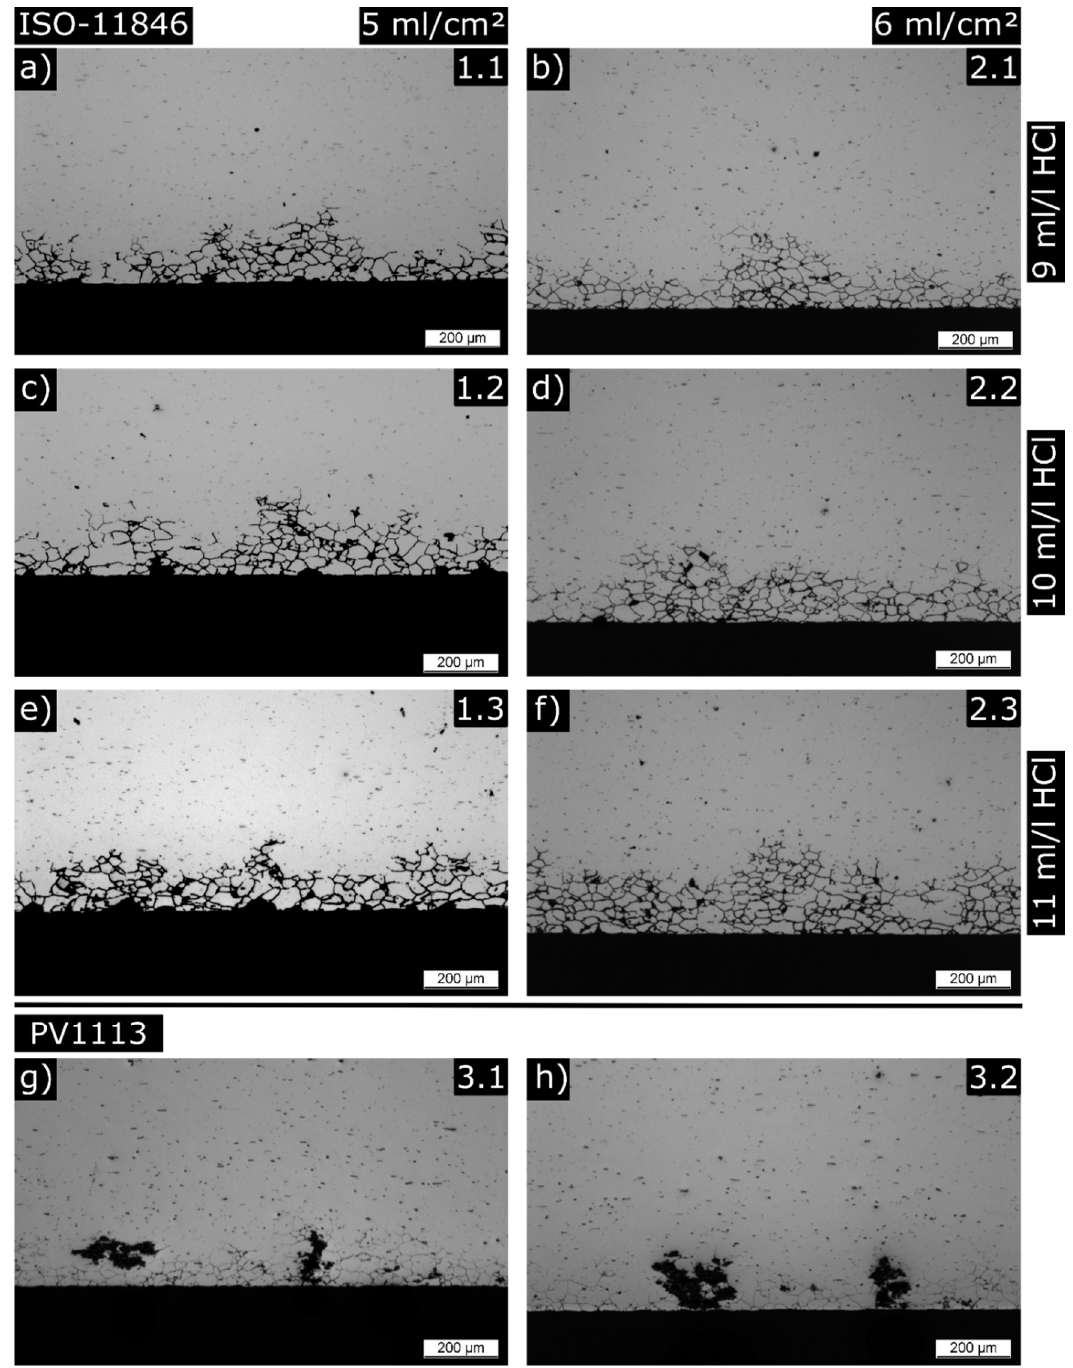
Figure 1. Representative micrographs of tested EN AW-6016 material. Three samples each were for the 5 mL/cm² ( a,c,e ) and 6 mL/cm² ( b,d,f ) testing solutions. Two samples were tested with the PV1113 ( g,h ).